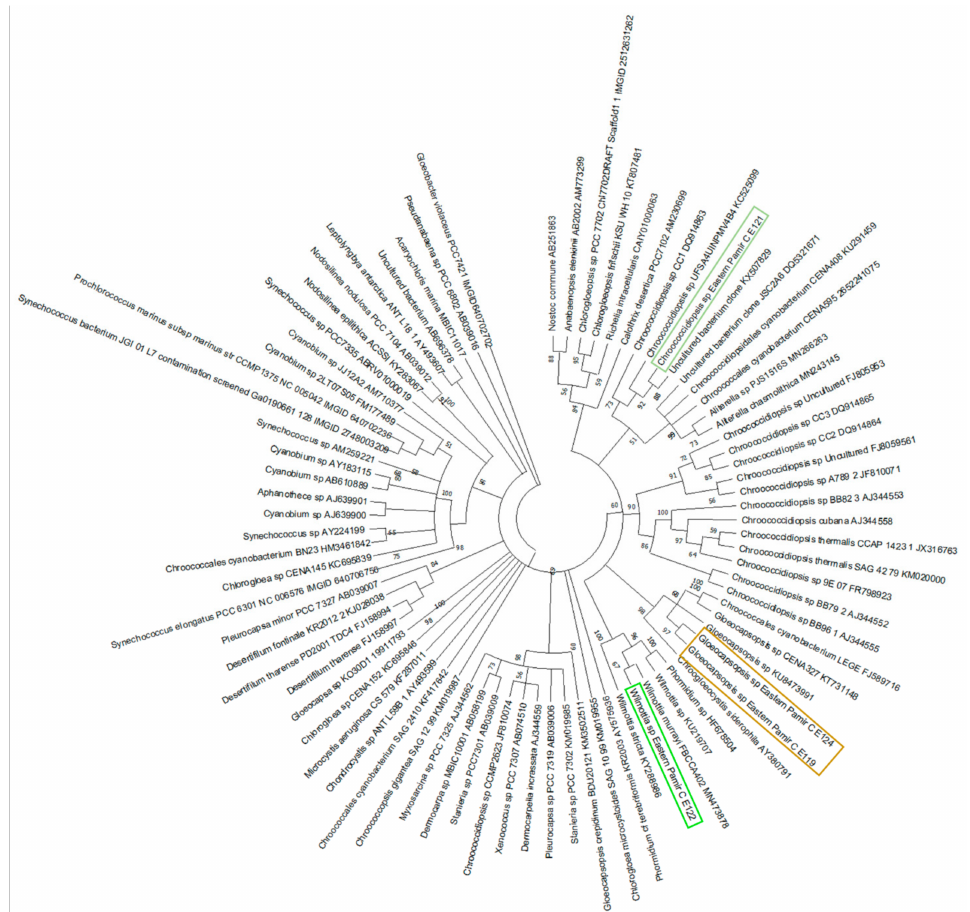
Figure 7. Maximum-likelihood tree based on 16S rRNA gene of cyanobacteria with the bootstrap of 1000. The sequences obtained within the present study are marked in light green ( Wilmottia sp. Eastern Pamir CE122), brown ( Gloeocapsopsis sp. Eastern Pamir CE119 and CE124) and dark green ( Chroococcidiopsis sp. Eastern Pamir